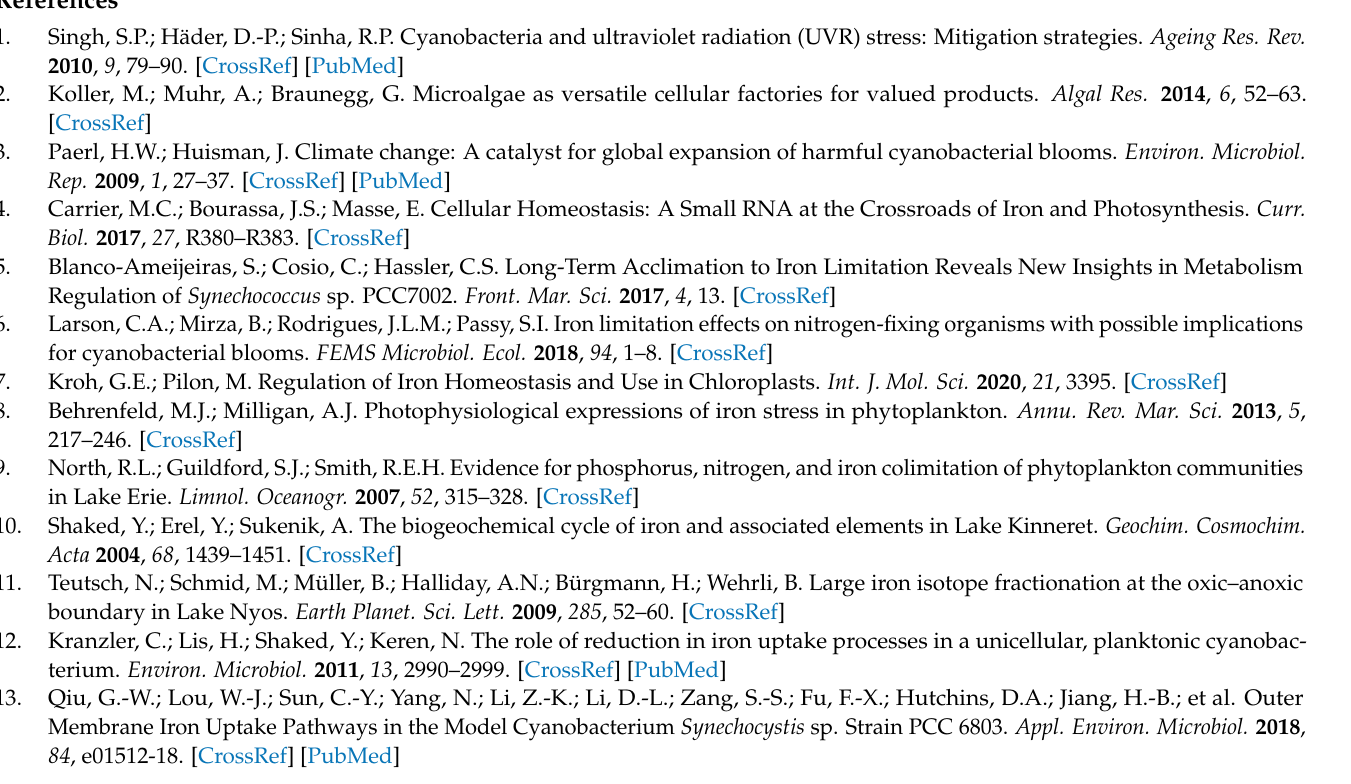
Figure S2. Volcano plot and MA plot of differentially expressed genes between Fe-1000 group and Fe-20 group; Figure S3. Volcano plot and MA plot of differentially expressed genes between Fe-1000 group and Fe-100 group; Table S1. Test results of total RNA quality; Table S2. Quality of sample sequencing data.; Table S3. Potential candidate genes associated with iron-limited stress